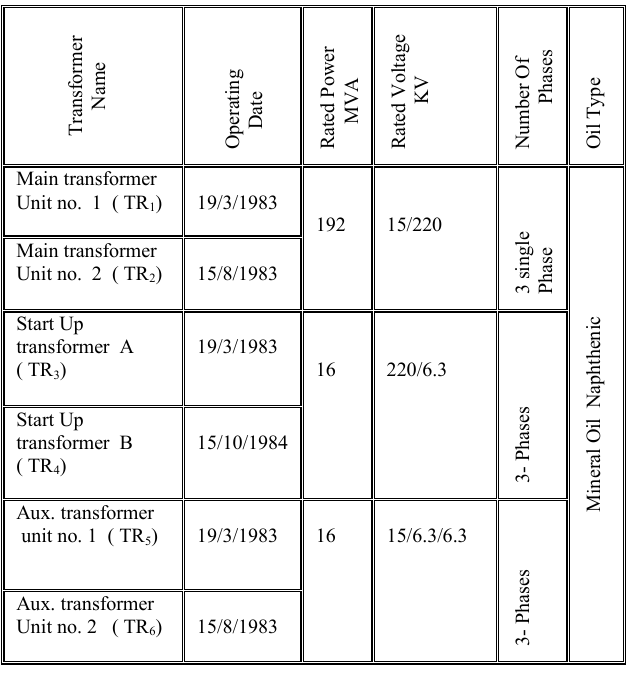
TABLE IV. (DGA) TESTING